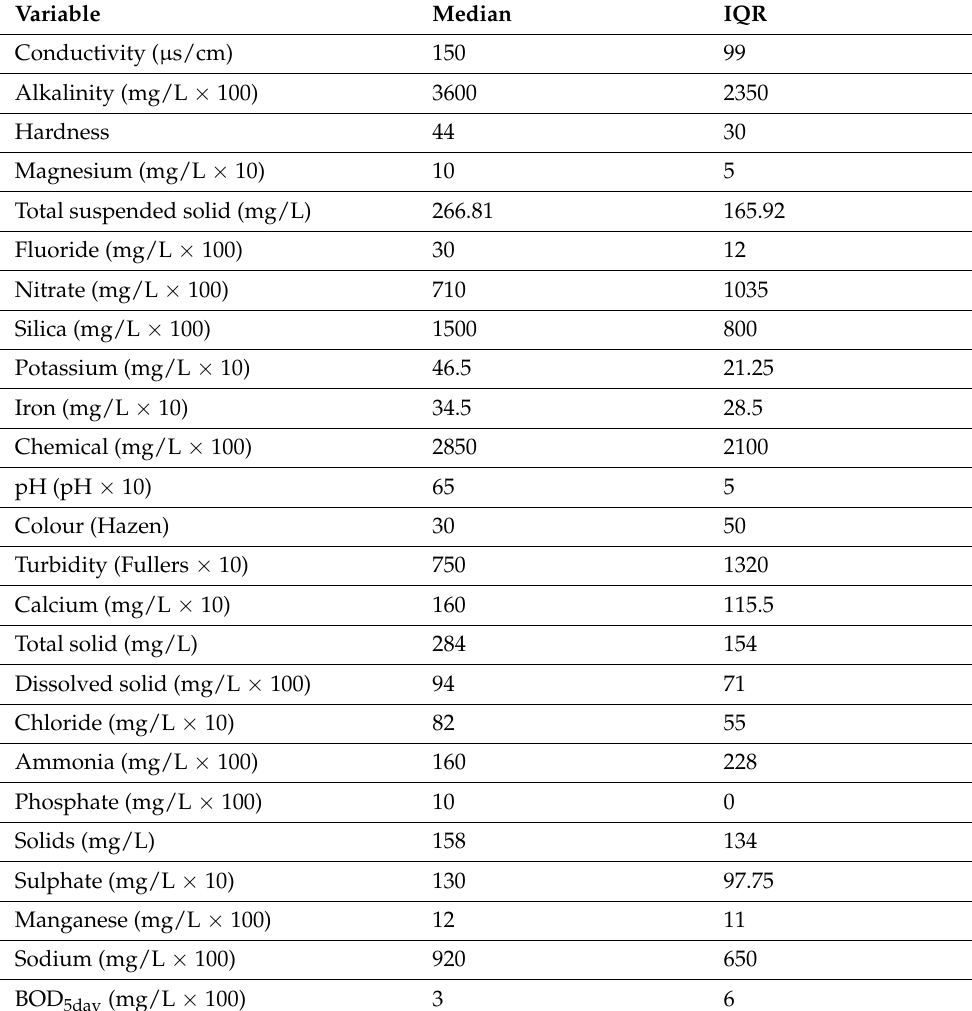
Table 1. The statistical analysis for water quality parameters based on the raw